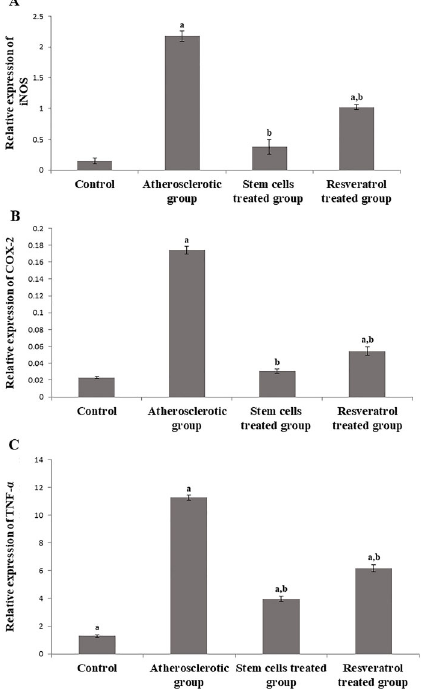
Figure 3. Inducible nitric oxide synthase (iNOS) ( A ), COX-2 ( B ), and tumor necrosis factor a (TNF- a ) ( C ) in rats experimentally induced with atherosclerosis and treated with stem cells or resveratrol. Data are reported as means ± SE. a P o 0.05 compared to control group; b P o 0.05 compared to atherosclerotic group